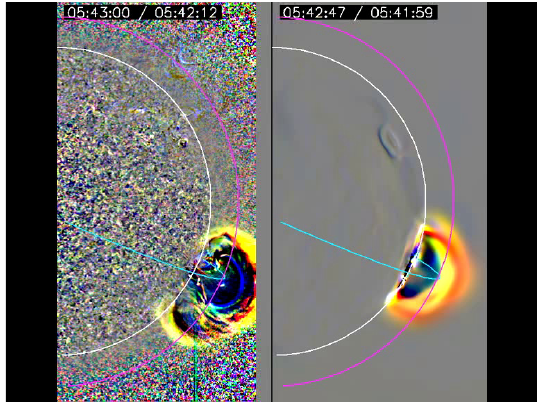
Figure 48: Still from a movie – An animation of the 2010 Jun 13 coronal wave observed in AIA tri-color running ratio images ( left ) and simulated with a 3D thermodynamic MHD simulation ( right ). Reproduced with permission from Downs et al. (2012), copyright by AAS. (To watch the movie, please go to the online version of this review article at http://www.livingreviews.org/lrsp-2015-3